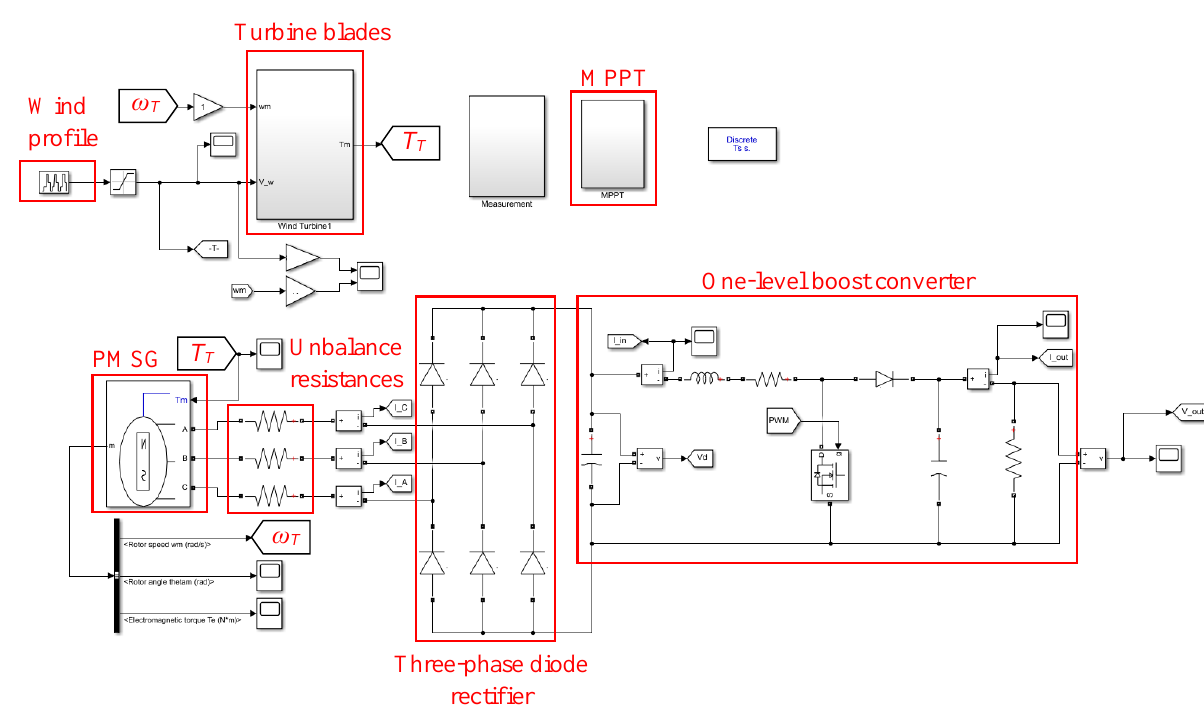
Figure 8. Model of direct–drive PMSG–based WT in Matlab/Simulink software. Table 1. Electrical and mechanical parameters of 12 kW direct–drive PMSG–based